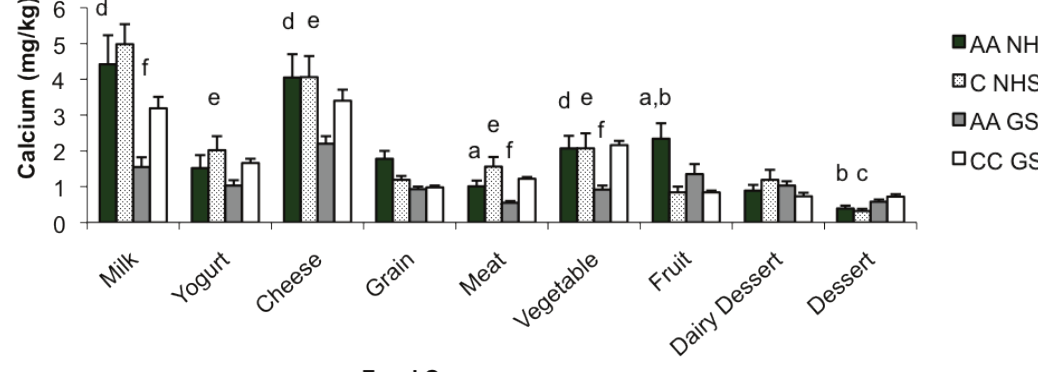
Figure 2. Intake of calcium, mg/kg body weight, (X ± SE) from various food sources among the Nutrition-Health Students (NHS) and General-Student Populations (GSP). AA = African Americans, C = Caucasian American, CC = Caucasian Croatian, a African American NHS differ significantly from Caucasian American NHS, b African American NHS differ significantly from Croatian students, c Caucasian American NHS differ significantly from Croatian students, d African American GSP students differ significantly from African American NHS, e African American GSP students differ significantly from Caucasian American NHS, f African American GSP students differ significantly from Croatian